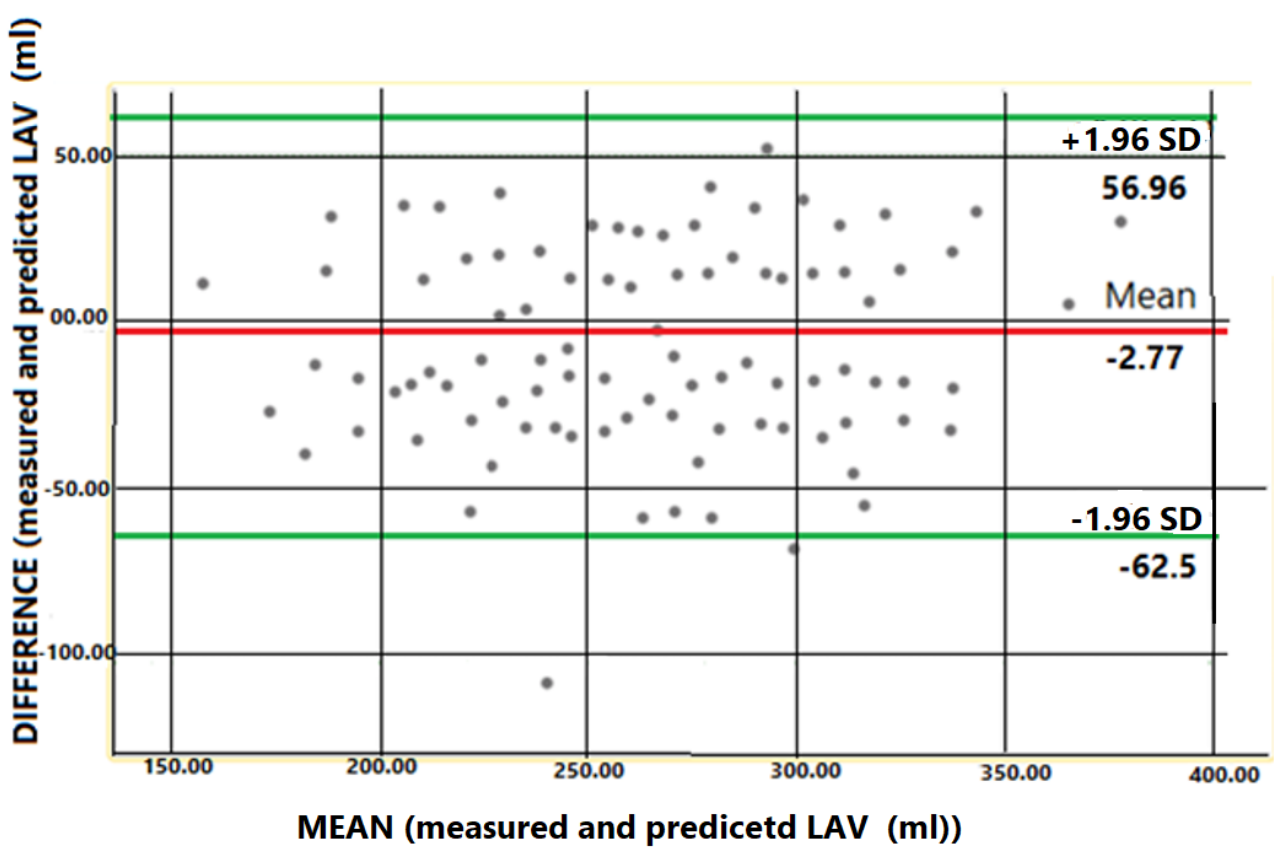
Figure 4. Bland–Altman test of agreement between measured left atrial volume and predicted left atrial volume using the following formula: 12 × MV area + 50 mL. The mean difference is depicted as a red solid line and 95 confidence intervals (CI) as dashed green lines.